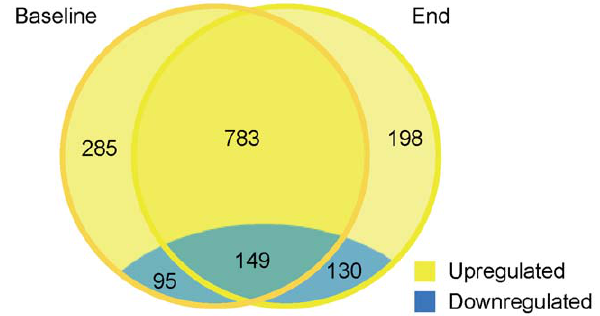
Figure 2. Venn diagram of differentially expressed genes by pregnancy. This figure presents the number of genes differentially expressed in third trimester pregnant versus nonpregnant women at study-baseline (circle on the left) and study-end (circle on the right). The number of genes altered both at study-baseline and study-end are presented in the intersecting area of the two circles. Color scheme: blue represents low expression and yellow represents high expression. n=12 for pregnant women; n=10 for nonpregnant women. Analyzed with the LEMMA statistical package.